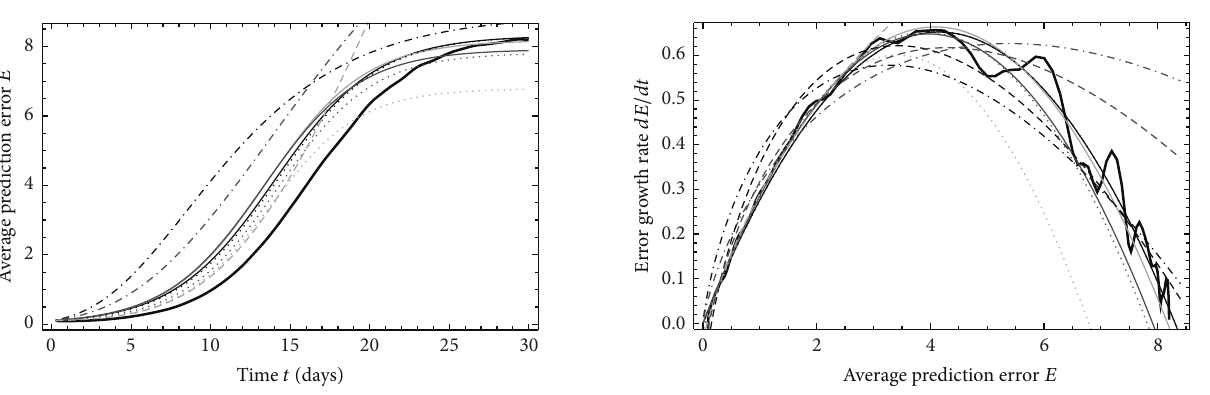
Figure 2: Time variations of the average prediction error 𝐸 for ND 1 , 𝑀 5 . The thick line represents data from EPS, the thin lines from (9), the dotdashed lines from (10), the dotted lines from (11), and dashed lines from NS (7). The light grey lines represent the data extrapolate from time length 𝜏 1 , the grey lines represent the data extrapolated from time length 𝜏 2 and black lines represent the data in time length 𝜏 3 .